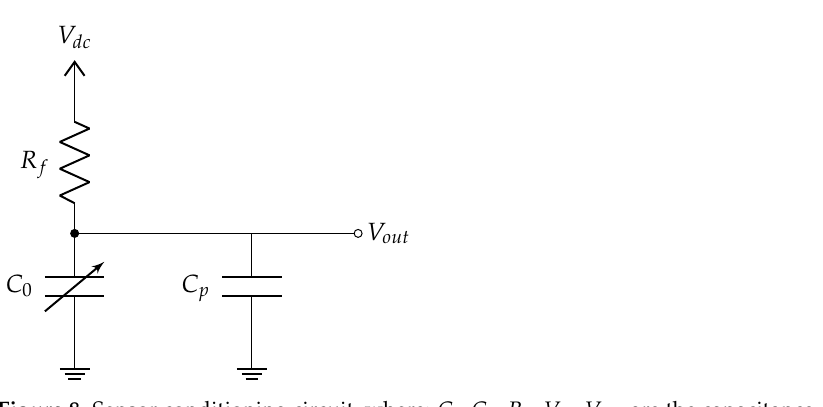
Figure 8. Sensor conditioning circuit, where: C 0 , C p , R f , V dc , V out are the capacitance of the cantilever, parasitic capacitance, resistance, polarization voltage, and output voltage,